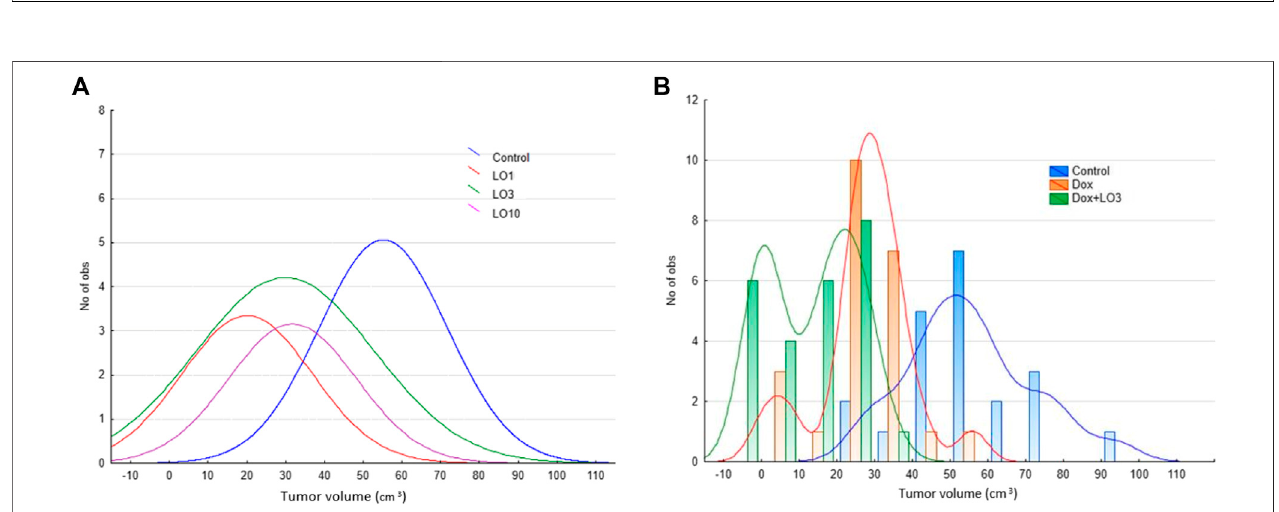
FIGURE 3 | The frequency distribution of PLS tumor volumes 11 days after the start of treatment and the estimation of distribution density using Gaussian smoothing method (A) and Gaussian Kernel methods (B) .